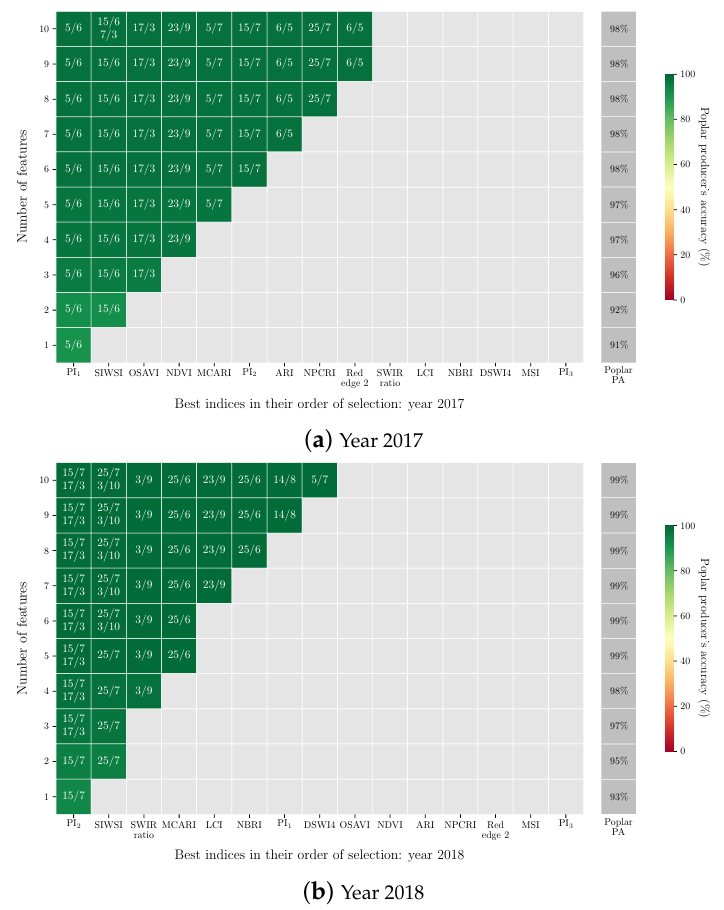
Figure 6. Average poplar PA as a function of the number of features selected with SFFS in the multi-index configuration: in ( a ), multi-index SFFS results in 2017; in ( b ), multi-index SFFS results in 2018. The y-axis represents the number of features, from 1 to a maximum of 10, and the corresponding spectral indices are listed in the x-axis in their order of appearance. The colours on the red-yellow- green scheme palette reflect the poplar’s PA values, also displayed in front of each number of features (grey cells on the right). The dates of the selected indices are given inside the cells. If a cell contains more than one date, it implies that the index was selected several times on different dates. Empty cells in light grey indicate that the index on the x-axis was not selected for the given number of features on the